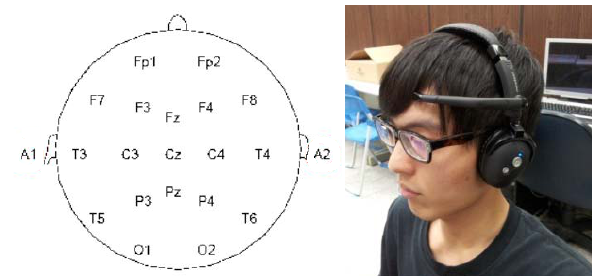
Figure 1. Brainwave collection points and a photo showing the device worn by a